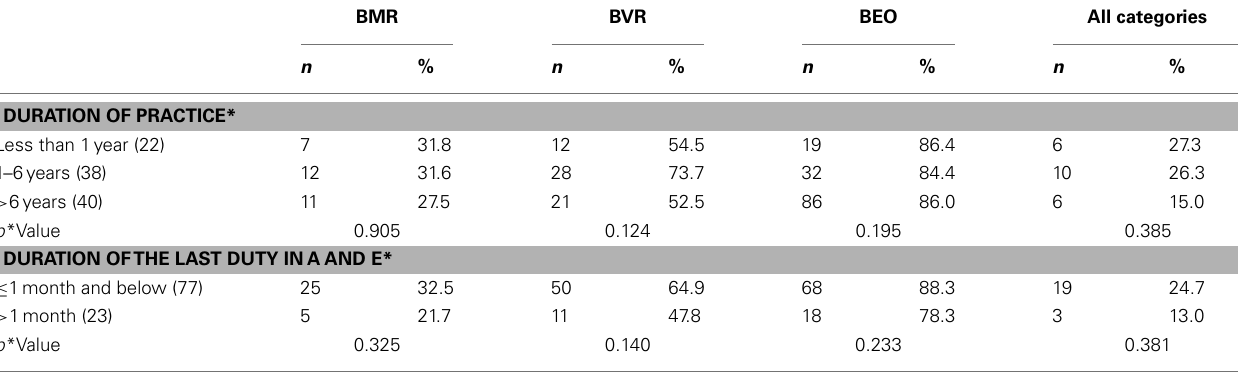
Table 3 | Participants who gave correct scores to the components of the clinical variables of the GCS (by duration of clinical practice and the last duty in theAccident and Emergency room).